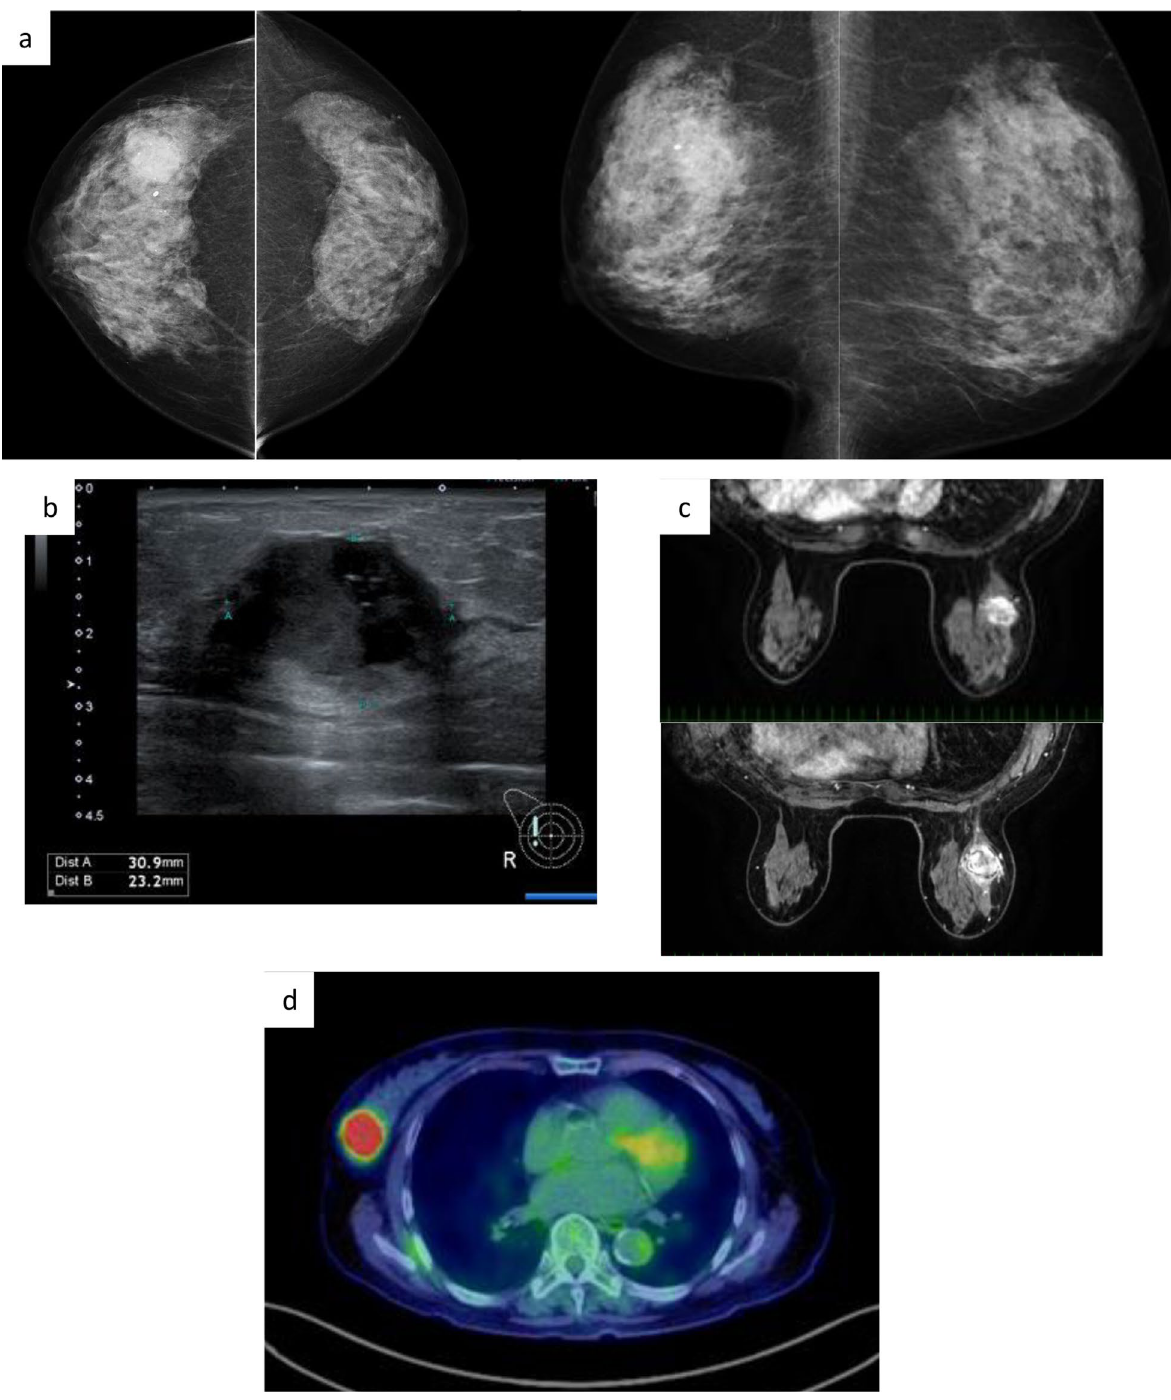
Fig. 1 Images of the patient at the first visit. a Mammography: high‑density mass shadow with obscure margin in the outside area of the craniocaudal outside and middle area of the mediolateral oblique. b Images of ultrasonography. Irregular nodule 31 Magnetic resonance imaging. Upper: early phase; Lower: late phase. Round mass with high intensity in T2 mode with rapid wash‑out sign. d Fluorodeoxyglucose (FDG)–positron emission tomography. High concentration of FDG in the upper‑outer region of the